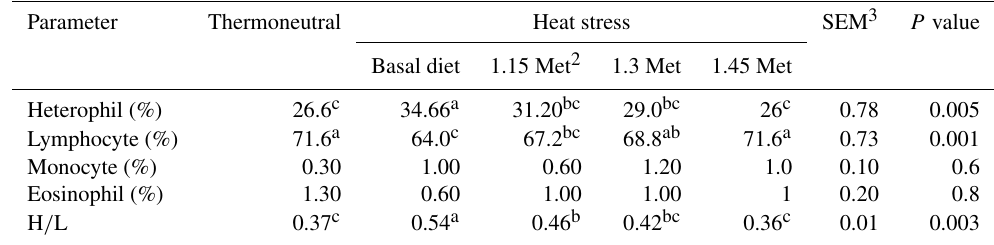
Table 7. Effect of methionine on heterophil, lymphocyte, monocyte, eosinophil and H / L 1 ratios in breeder quails.